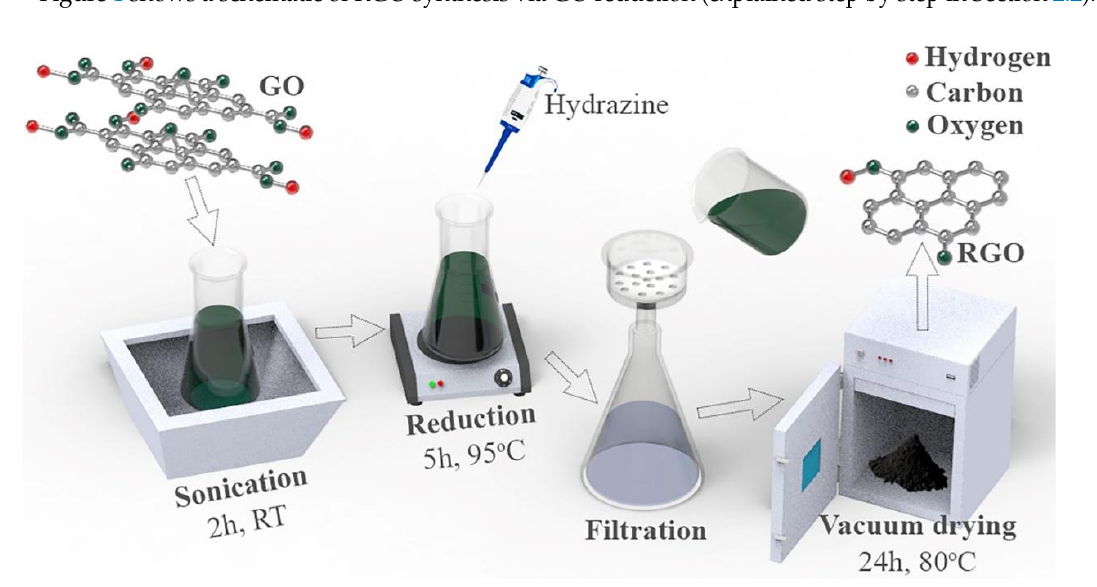
Figure 1. Schematic of RGO synthesis.